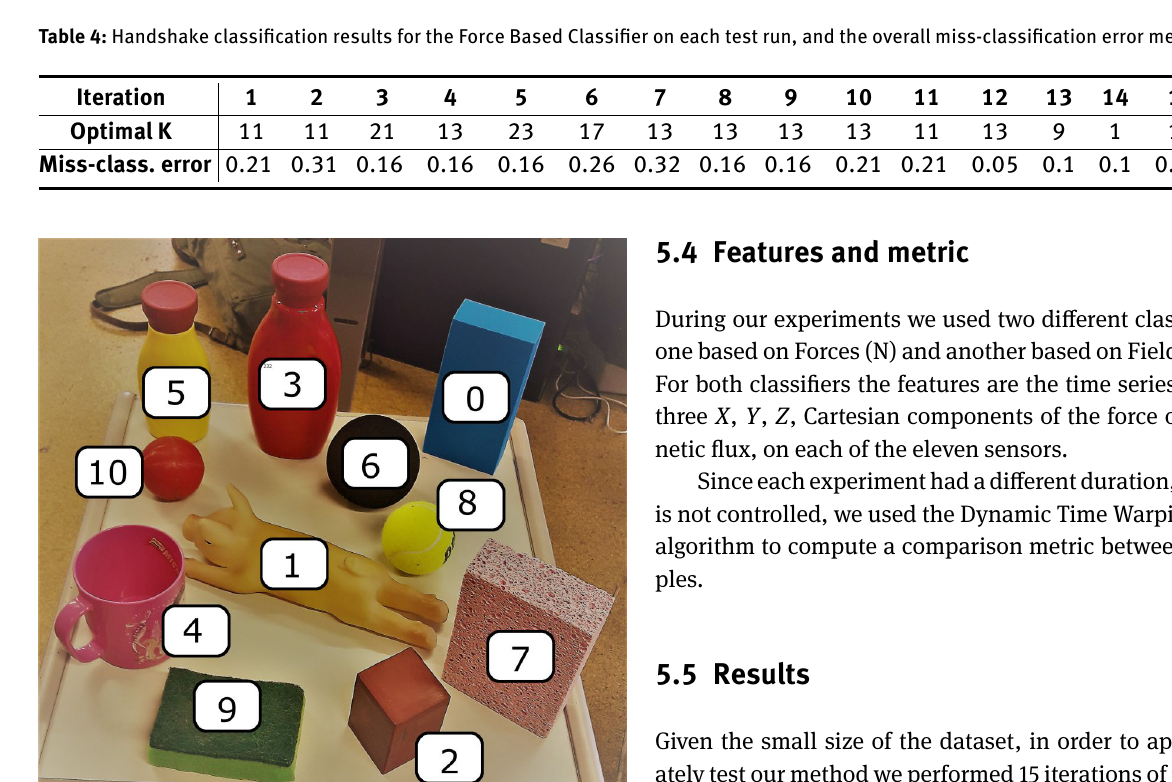
Figure 6: Objects used as the “no hand" class.